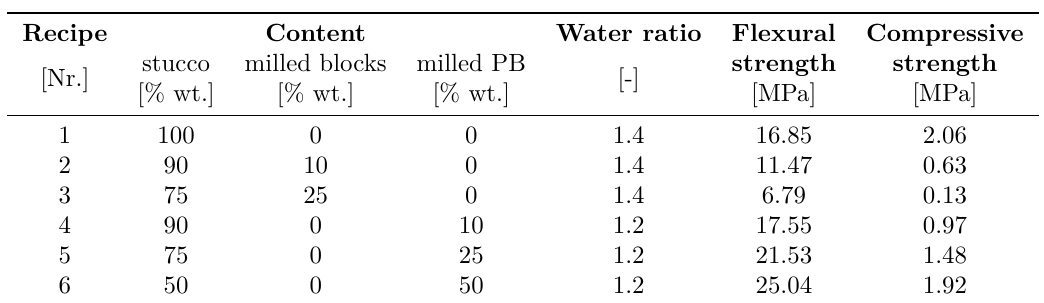
Table 2. Flexural and Compressive strength.